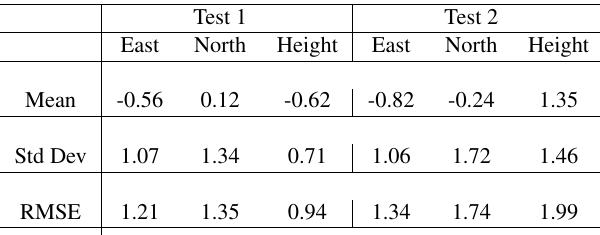
Table 1: Navigation results: Test 1